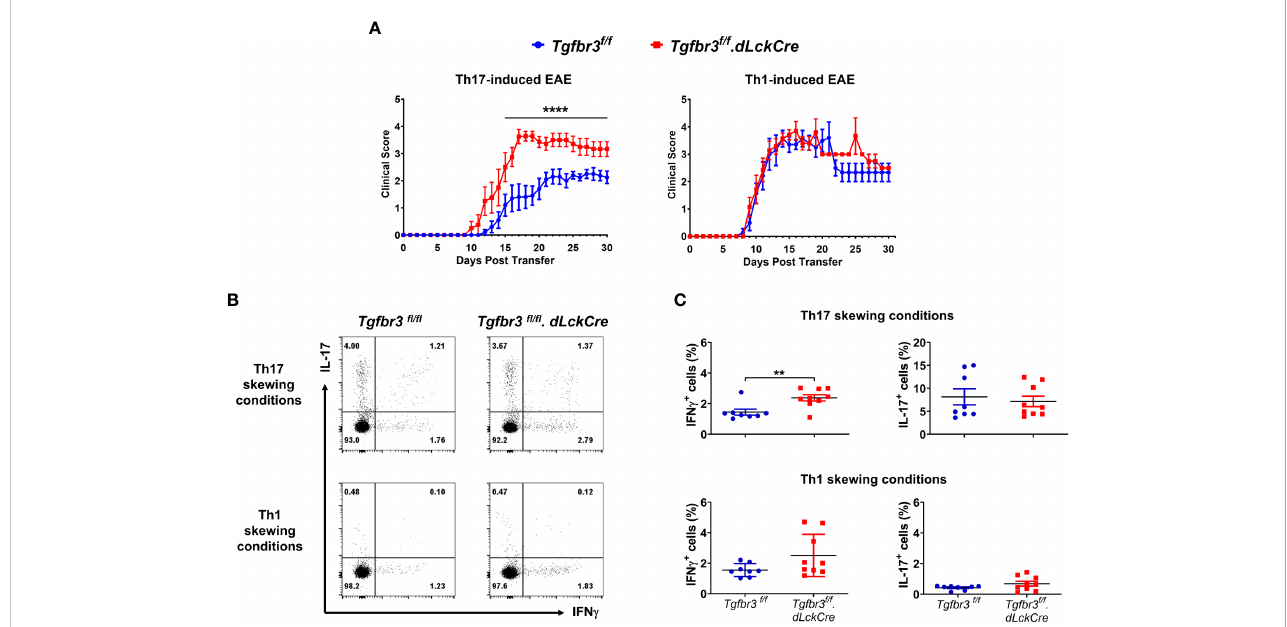
FIGURE 6 T b RIII regulates the ability of encephalitogenic Th17 to induce EAE. Encephalitogenic Th17 or Th1 cells were generated from Tgfbr3 fl / fl (blue) or Tgfbr3 fl / fl .dLcKCre (red) donor mice and transferred to naïve Tgfbr3 fl / fl recipients. (A) Clinical scores of passive EAE after transfer of encephalitogenic Th17 and Th1 T cells from both strains into naïve wild-type recipients. The data is expressed as mean ± SEM. For Th17 transfer experiments: T b RIII control (n=10) and T b RIII null (n=8). For Th1 transfer experiments: T b RIII control (n=7) and T b RIII null (n=7). Non parametric ****p ≤ 0.0001. (B, C) Frequency of IL-17 and IFN- g expressing Th cells in Th17 skewed or Th1 skewed cultures of T cells from MOG 35-55 peptide immunized Tgfbr3 fl / fl or Tgfbr3 fl / fl .dLcKCre mice. (B) Representative dot plots (left) and scatter plots (right). Each dot in the scatter plot represents an individual mouse and data is mean ± SEM. Parametric student t-test **p ≤